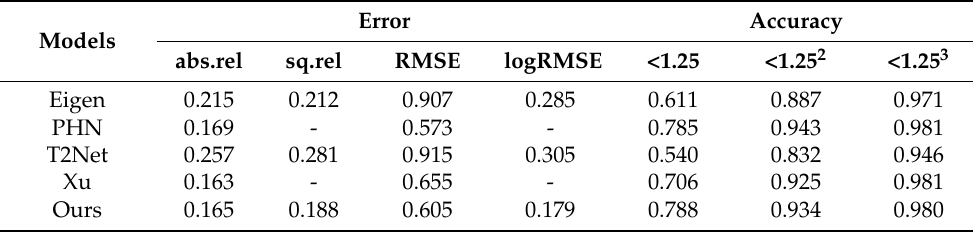
Table 2. Comparison between our method and other methods on the NYU depth V2 dataset.